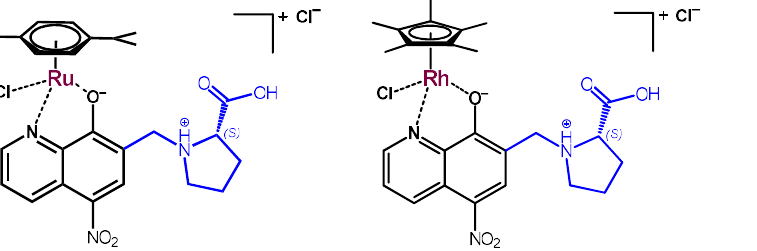
Table 1. p K a values of HQNO 2 -L-Pro determined by various methods. { t = 25.0 °C}.